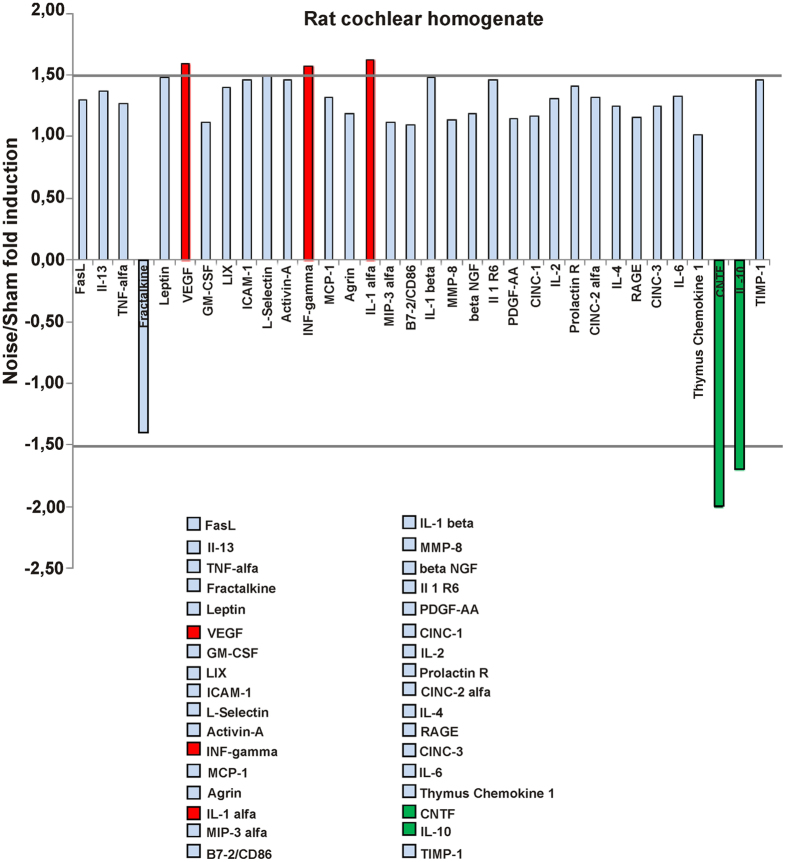
Noise induces a proinflammatory and proangiogenic response in rat cochlea.Bar histogram illustrating the differential expression of 34 cytokines in the cochlear homogenates of Noise-exposed and Sham-treated Wistar rats (pools of 5 cochleae from 5 animals/group), simultaneously evaluated by a commercial antibody array. Values are Noise-to-Sham ratios (fold induction if >1 or fold reduction, i.e. −1/fold induction, if <1) calculated from duplicate spots for each cytokine. Cytokines displaying a fold induction or a fold reduction >1.5 (with p < 0.05 by t-test) were highlighted in red or green, respectively. Picture representative of two independent hybridizations.